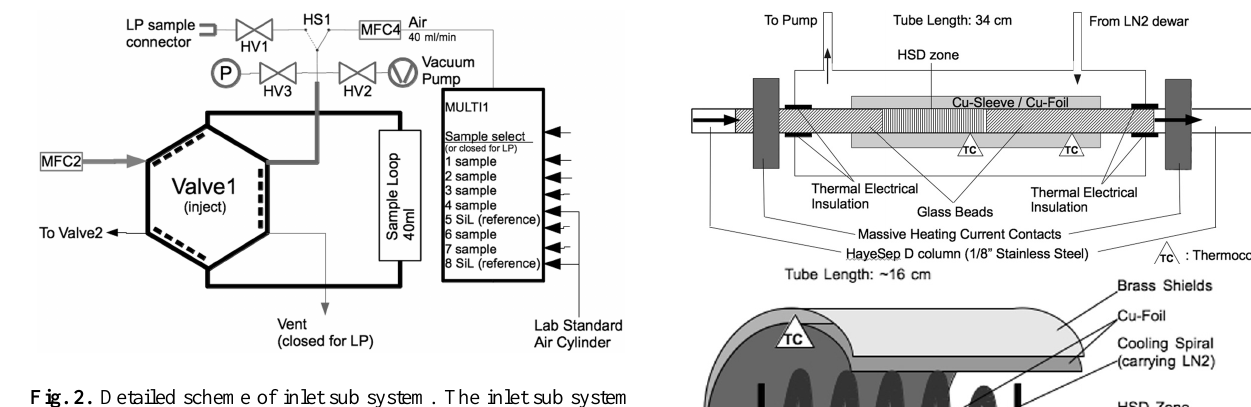
Fig. 2. Detailed scheme of inlet sub system. The inlet sub system can be chosen to either operate automatically on sample containers at high pressure or to analyze containers at low pressure manually. The default position of Valve1 is indicated by dotted lines.